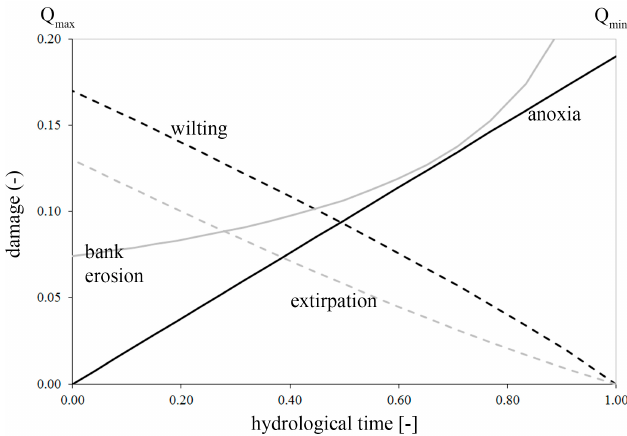
Figure 2. Example of damage variations related to the hydrological time, starting from the maximum discharge Q max at t = 0 to the minimum discharge Q min at t = 1.